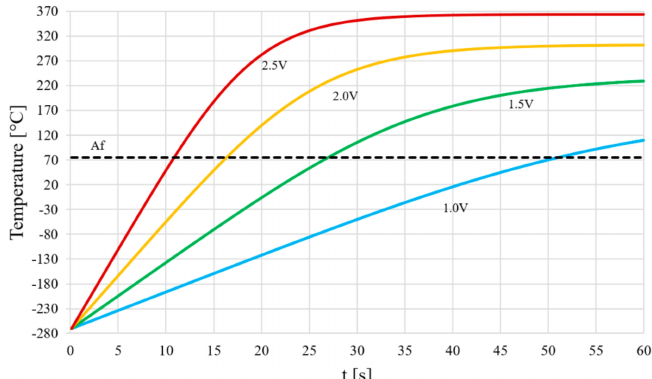
Figure 5. Temperature-Time graph for SMA element in the space environment with di ff erent applied voltages.